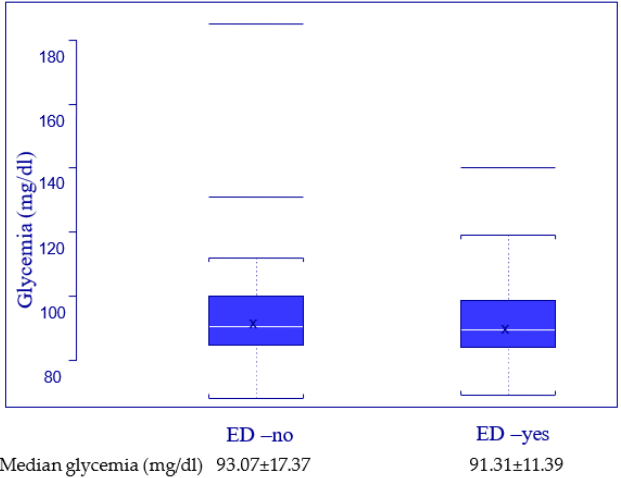
Figure 5. Glycemia related to erectile function.